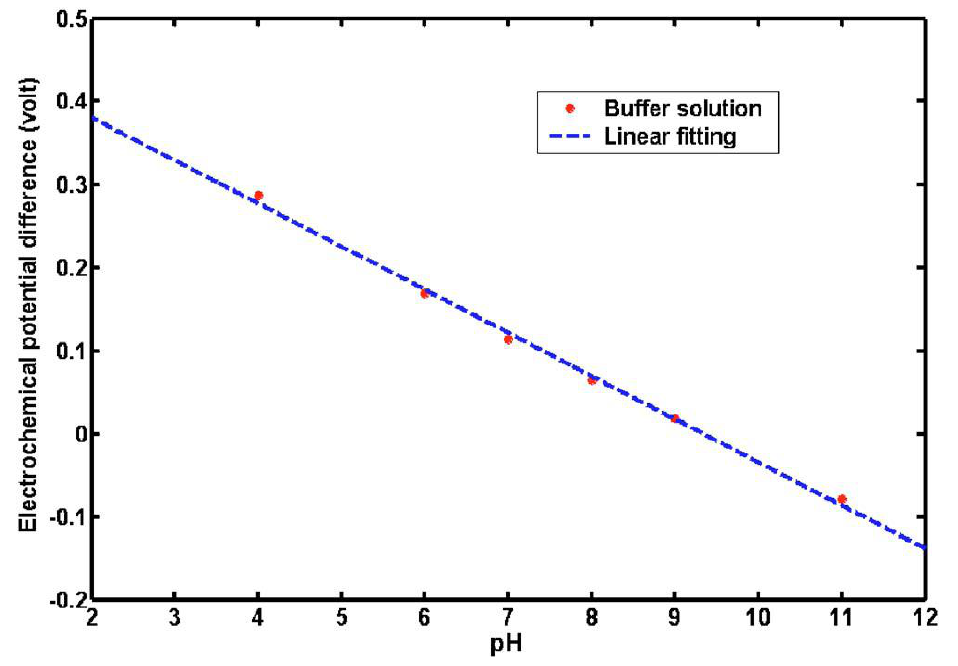
Figure 1 7 . Calibration curve showing the electrochemical potential difference for ZnO nanorods as a working electrode with a Ag/AgCl reference microelectrode vs pH changes for buffer solutions (adopted from Ref.